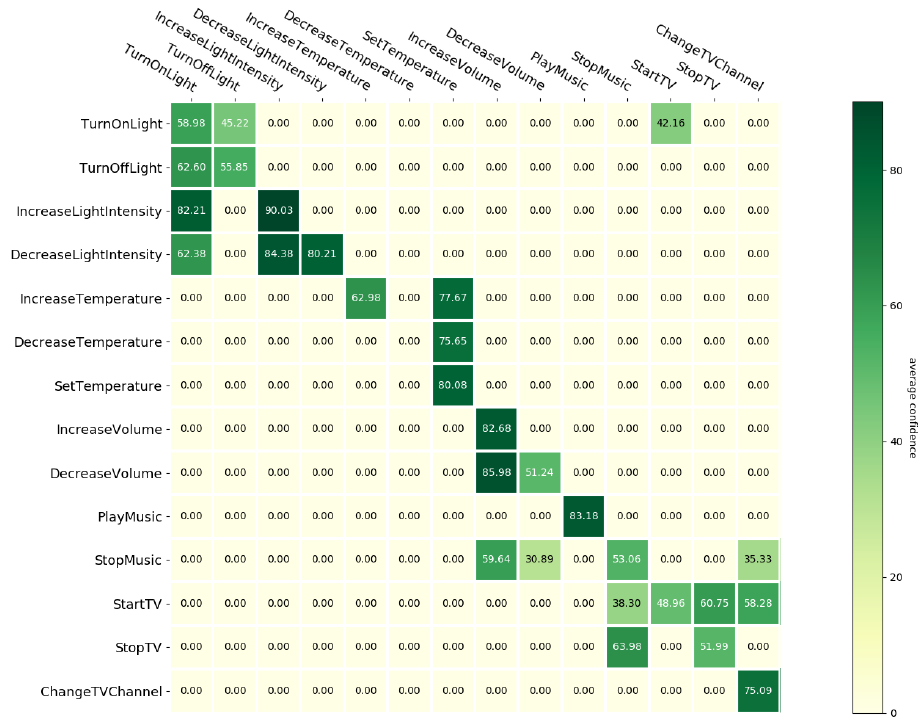
Figure 6. Confidence matrix for Scenario